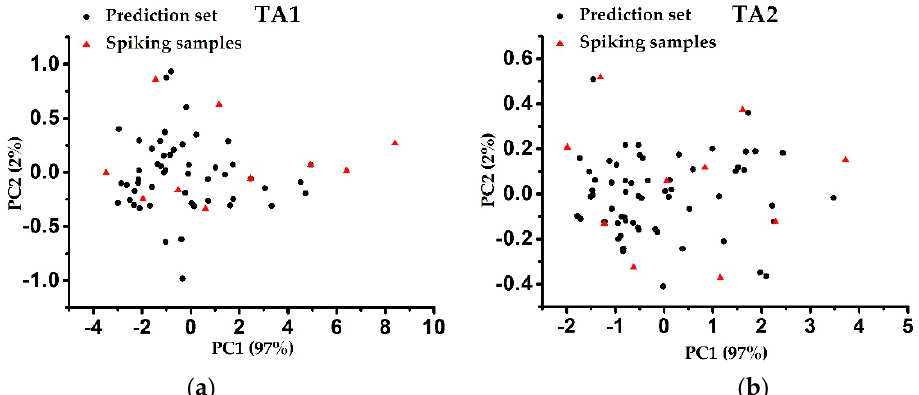
Figure 2. Score plots of ( a ) TA1 and ( b ) TA2 soil samples in principal component space defined by the first two principal components.